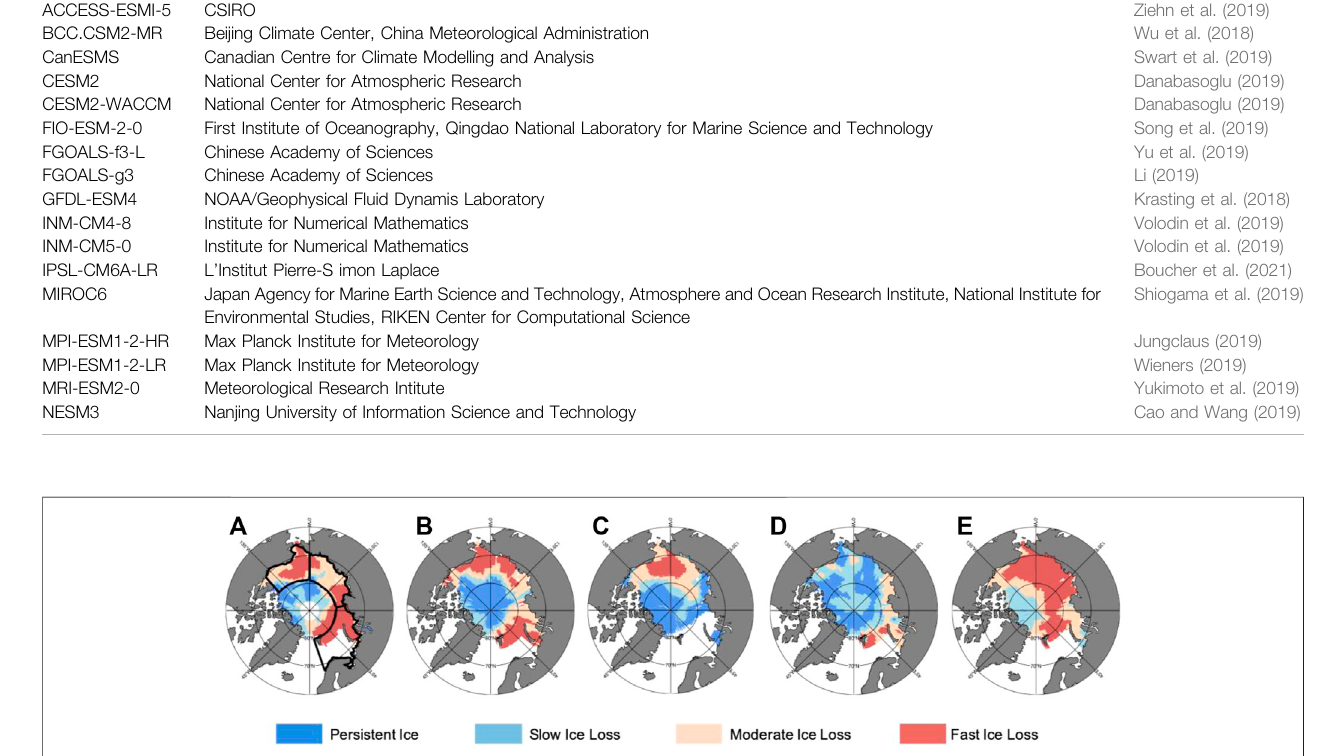
FIGURE1| Winter (October-January) sea iceloss regimesfor observations (A) and four CMIP6 models (B – E) ACCESS-CM2,CESM2-WACCM, INM-CM4-8 and MRI-ESM2-0. Whiteand grey (land) portions are areas notincluded inourdiscussion. Blacklines denote regions ofinterest (clockwise): Beaufort-Chukchiseas,Laptev- East Siberian seas, Barents-Kara seas and the Central Arctic in the areas around the North